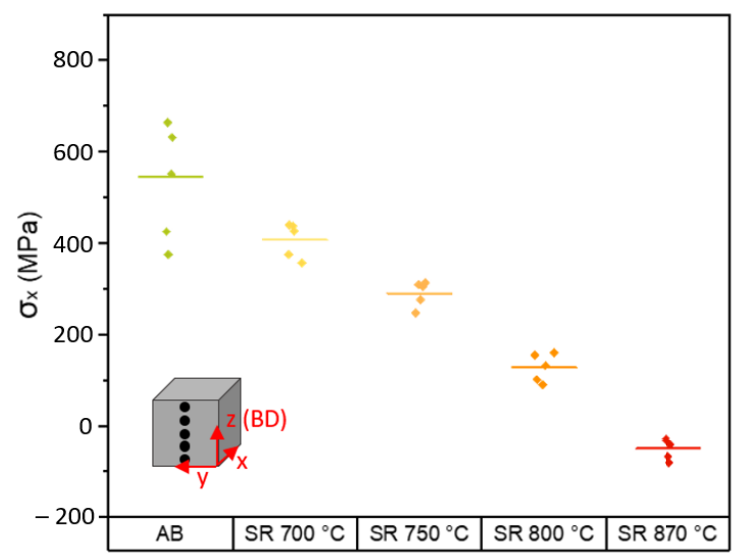
Figure 4. Residual stresses measured by high-energy X-ray diffraction in as-built and stress- relieved